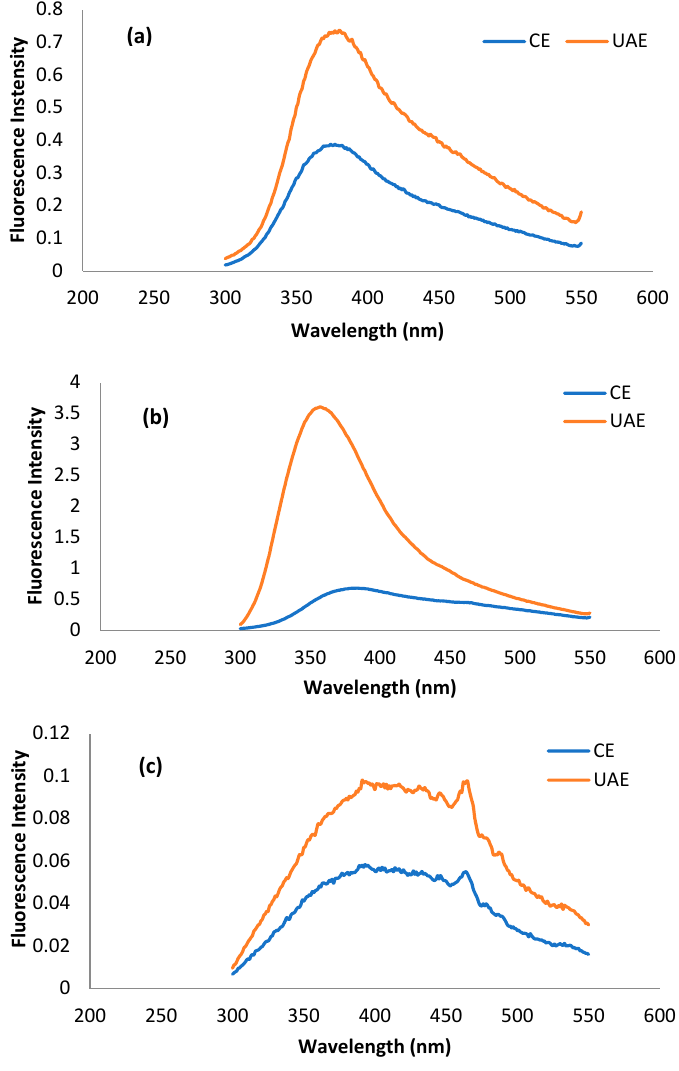
Figure 5. Fluorescence spectra of tryptophan ( a ), phenylalanine ( b ), and tyrosine ( c ) residues for the MOSP from CE and UAE.